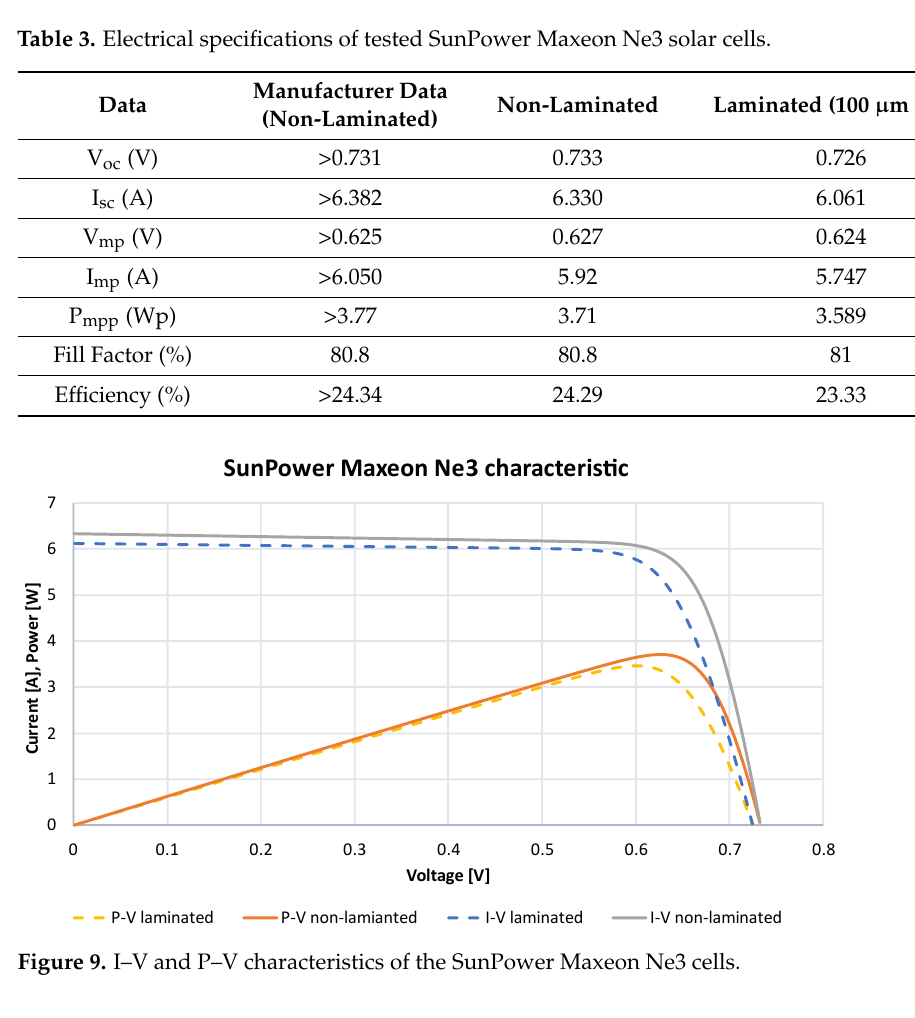
Table 4. Specification of tested SunPower Maxeon Ne3 solar cells. Data